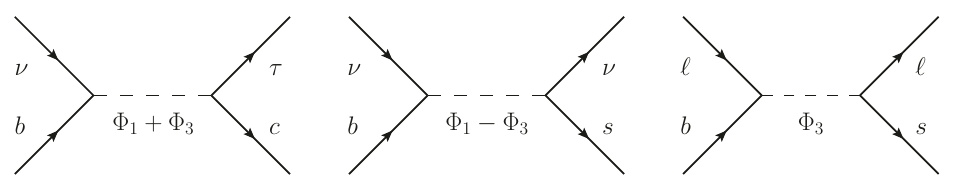
Figure 1 . Feynman diagrams contributing to b contribute to b c(cid:28)(cid:23) and b s(cid:23)(cid:23) but only (cid:8) 3 to b ! ! couplings to fermions, the LQs interfere constructively (destructively) in b naturally R ( D ) =R ( D ) = R ( D (cid:3) ) =R ( D (cid:3) ) SM Adding couplings to muons, we can also address the b like contribution. Finally, adding a (small) right-handed coupling of (cid:8) explain a (cid:22)